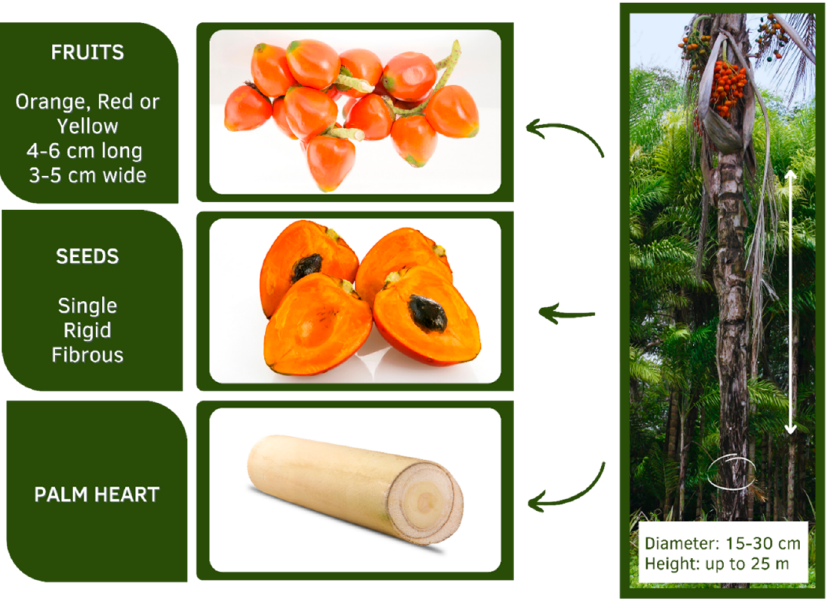
Figure 1. The peach palm tree and its commercially exploited parts (products), namely fruits, seeds, and palm